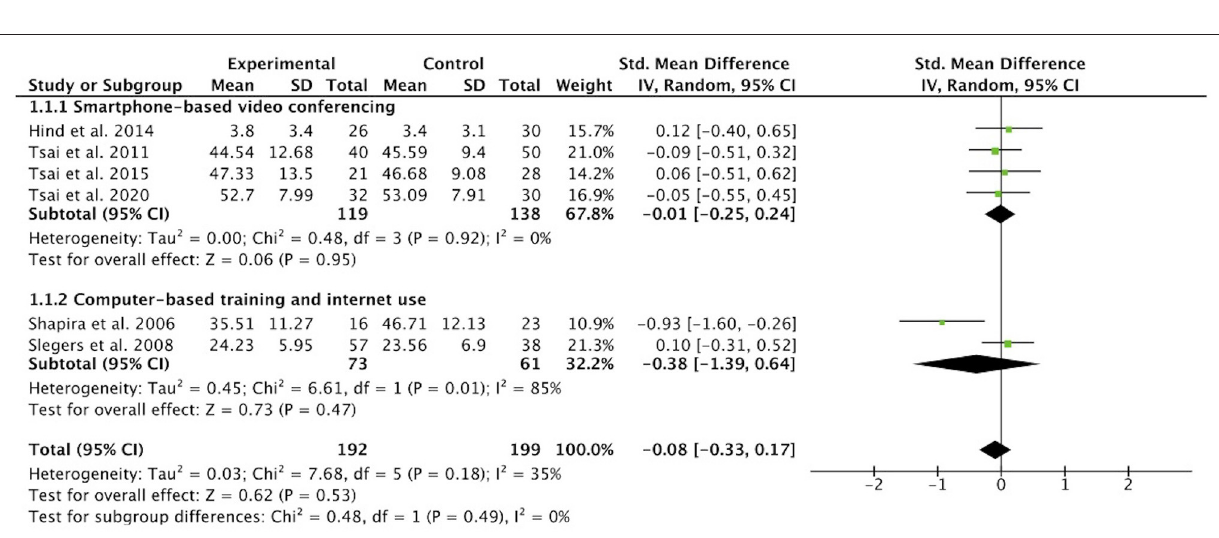
FIGURE 4 | Subgroup analysis: effect size of computer-based interventions or smartphone-based interventions vs. control groups in reducing loneliness in older